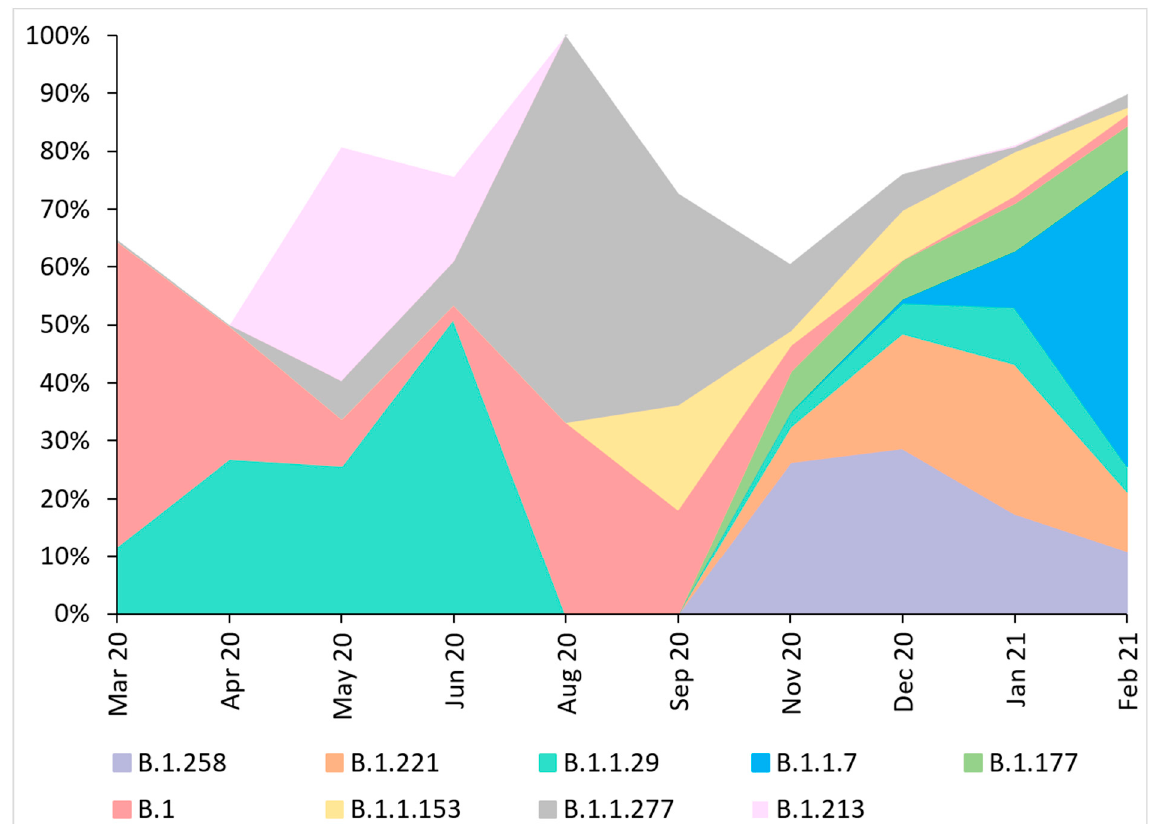
Figure 1. Lineage size breakdown of Poland genomes collected each month. Distribution of major nine SARS-Cov-2 lineages circulating in Poland between March 2020 and February 2021, estimated based on whole-genome sequencing. No data on the sequences collected in July and October 2020 were available. Displayed codes indicate virus variants based on PANGO classification. During the first month of analysis, the dominant virus variant was lineage B.1 (20A), with 27 cases observed in March 2020 (52.94%), and lasted during the entire period of sampling. In April and June 2020, variant B.1.1.29 (20A) dominated in 20 (27.03%) and 21 (51.22%) of sequenced isolates, respectively. In May, lineage B.1.213 (20A) appeared, which accounted for 40.32% (n = 25) of cases. In August and September, the most common virus type was B.1.1.227 (20B), at 66.67 (n = 3) and 36.36% (n = 4), respectively. In the next two months, the B.1.258 (20A) variant dominated (n = 30 (27.27%) for November and n = 47 (29.19%) in December). In January 2021, the main virus strain was B.1.221 (20A) (n = 115 (26.08%)). February showed the highest contribution of variant B.1.1.7 (20I/501Y.V1) with 79 cases (51.97%).